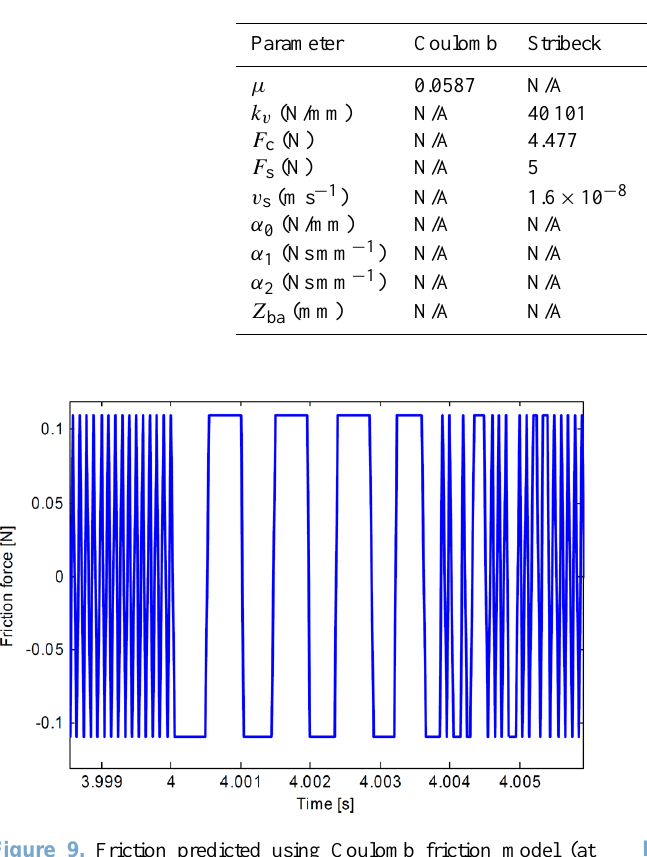
Figure 10. Sliding speed predicted using Coulomb friction model (at around the 4th second).